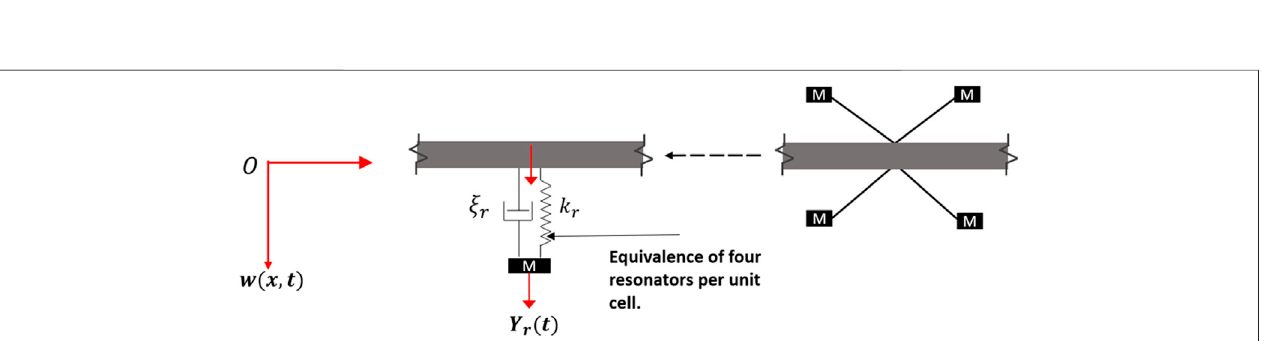
FIGURE3| Freebodydiagramofalocalresonator.Thefourlocalresonatorsactingatapointintheunitcellarereducedintoanequivalentsinglelocalresonatorunit cell in the model.